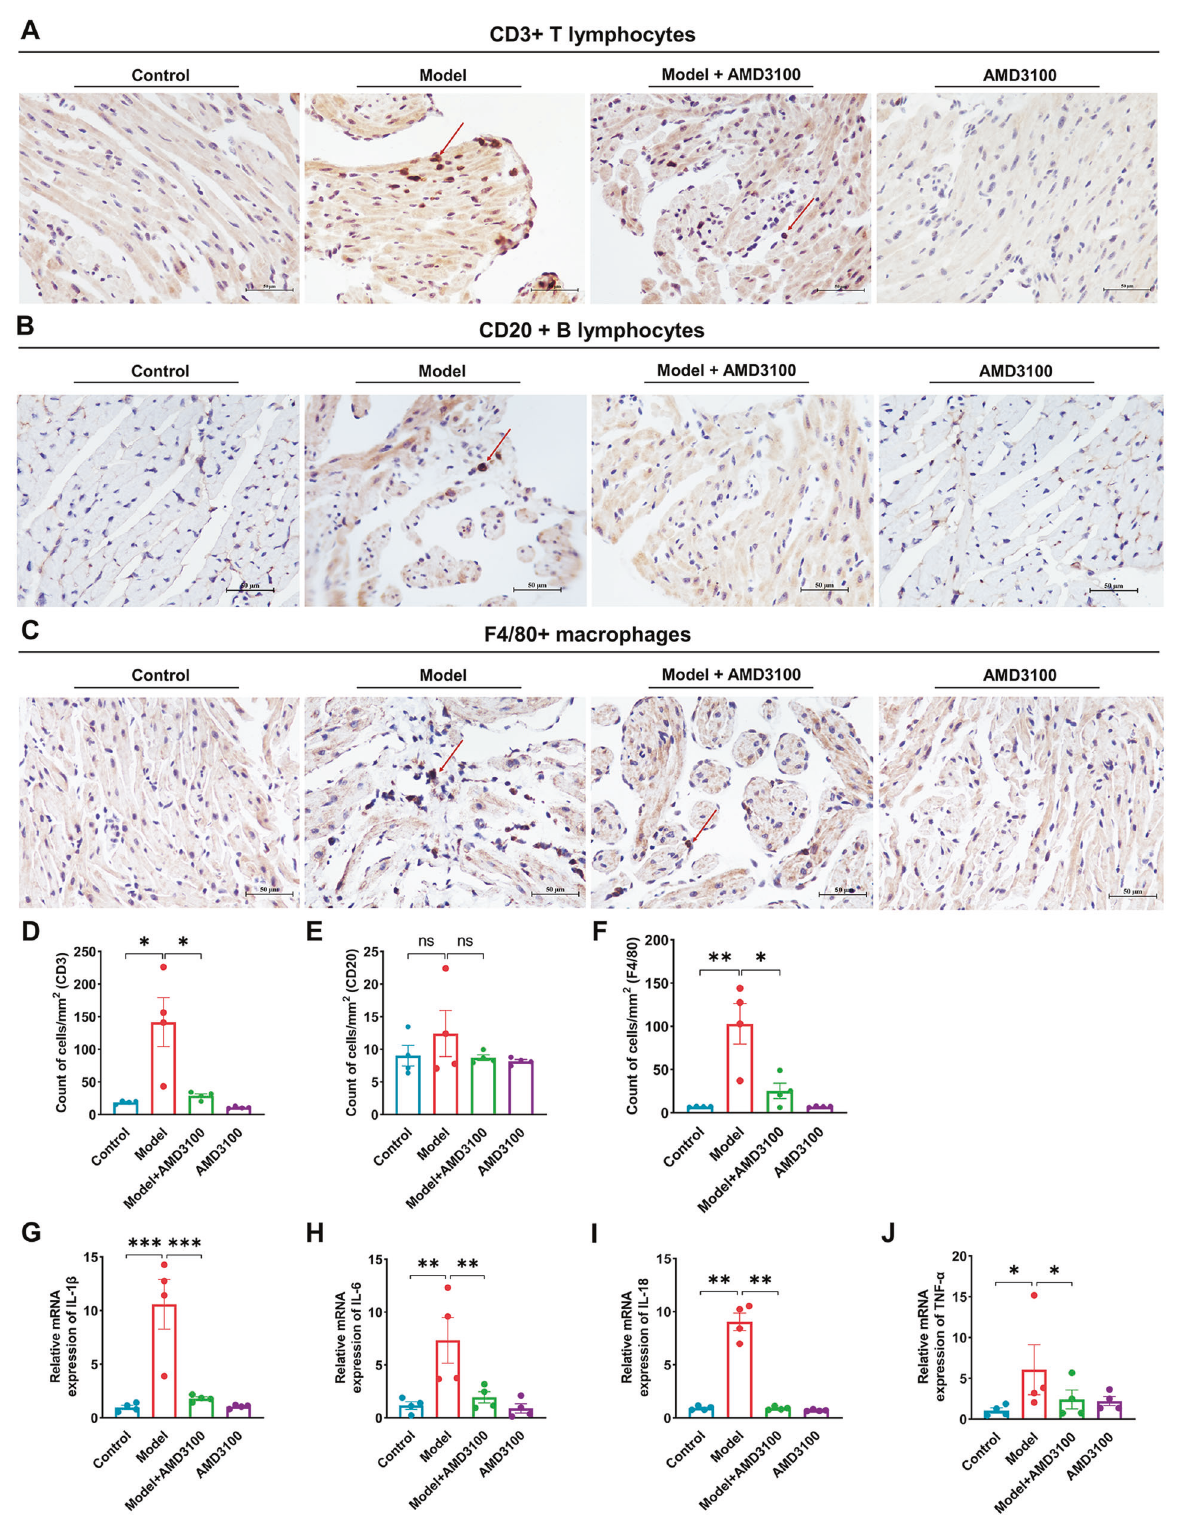
Fig. 5 AMD3100 administration prevents the in fi ltration of CD3 + T lymphocytes and F4/80 + macrophages and inhibits the activation of proin fl ammatory. A , D Immunohistochemical staining of T lymphocytes with an anti-CD3 antibody and quanti fi cation of the CD3 + cells ( n = 4). B , E Immunohistochemical staining of B lymphocytes with an anti-CD20 antibody and quanti fi cation of the CD20 + cells ( n = 4). C , F Immunohistochemical staining of macrophages with an anti-F4/80 antibody and quanti fi cation of the F4/80 + cells ( n = 4). G – J The qPCR analysis of the mRNA levels of IL-1 β , IL-6, IL-18, and TNF- α in the atria from four groups ( n = 4). Scale bar: 50 μ m. Results are expressed as the mean ± SEM, and n represents the number of animals in each group. ns P > 0.05, * P < 0.05, ** P < 0.01, *** P < 0.001.